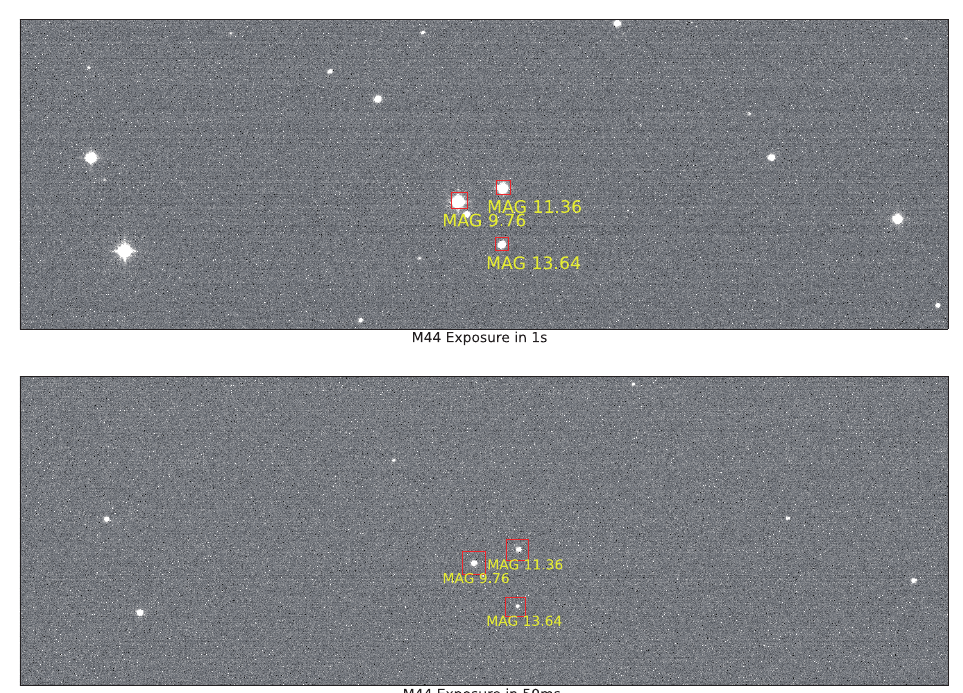
Figure 3. AST3-3 Images for M44 with 1000 ms and 50 ms exposures. The image with a one-second exposure was taken at an altitude of 65 degrees, and the 50 ms exposure image was taken at 78 degrees. The bright stars in the field are circled and marked with their magnitude from the SDSS DR7 catalogue